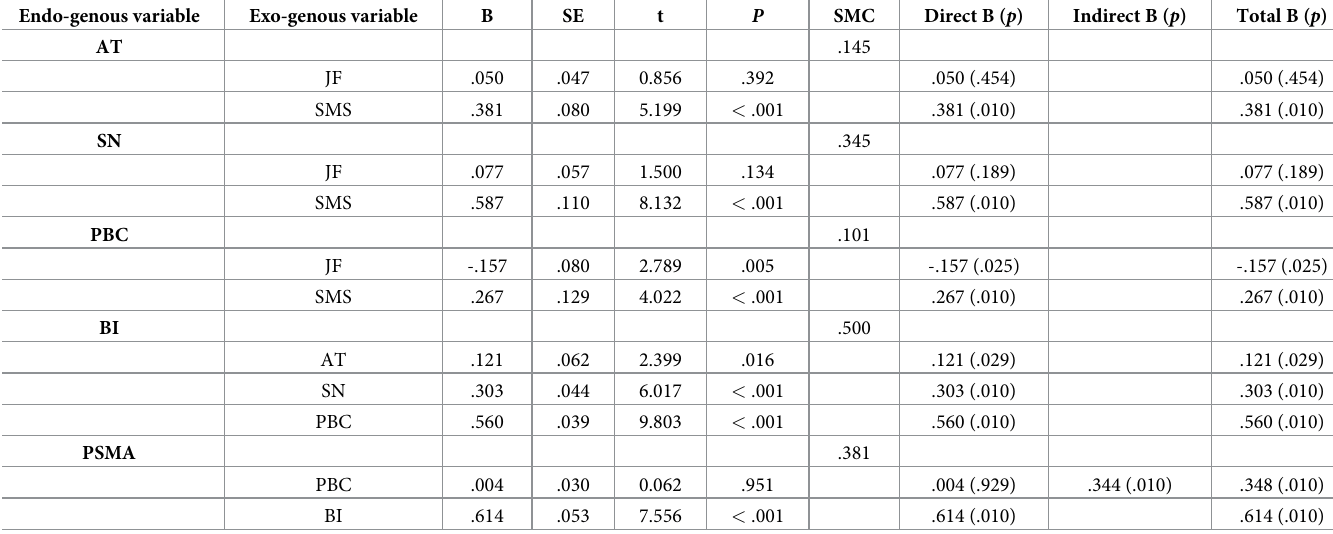
Table 3. Results of the conceptual model analysis. Endo-genous